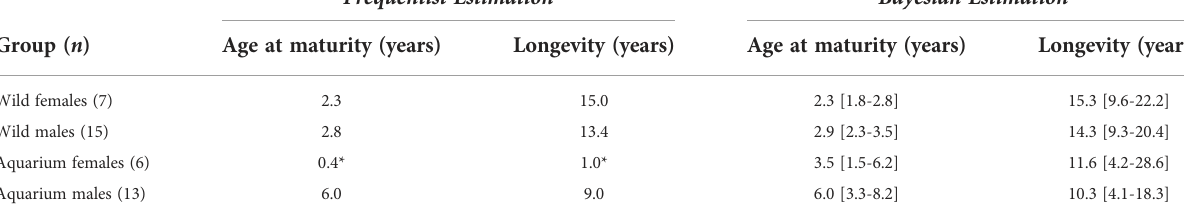
TABLE 6 Life history characteristics inferred from von Bertalanffy growth curves.